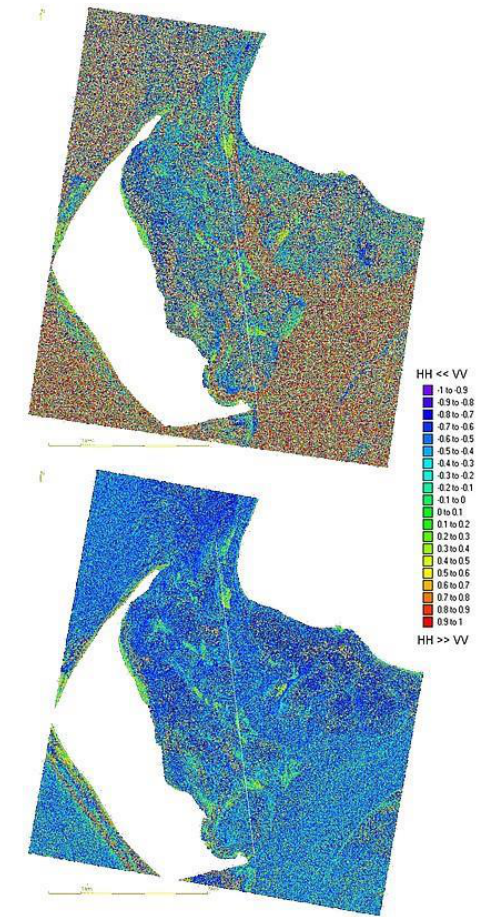
Figure 5. Polarization coefficient (normalized difference polarization ratio) calculated from dual-polarization TSX SAR images of the “Amrum” test site acquired on (upper) June 6 and (lower) June 22, 2013. Included as a vertical white line is the transect, along which the curves in Figure 6 were calculated At the time of the first image acquisition (June 6; upper panel) the wind conditions were 4.3 m/s / 26° and during the second image acquisition (June 22; lower panel) they were 10.0 m/s / 228°. Both islands, Amrum on the left and Föhr on the upper right, were masked out in both panels. Open flats appear in bluish (cyan to dark blue) colors, indicating higher backscatter at vertical polarization; however, several green patches with sharp edges can be seen on the open flats, between the two field campaigns. The oysters, being arranged irregularly within